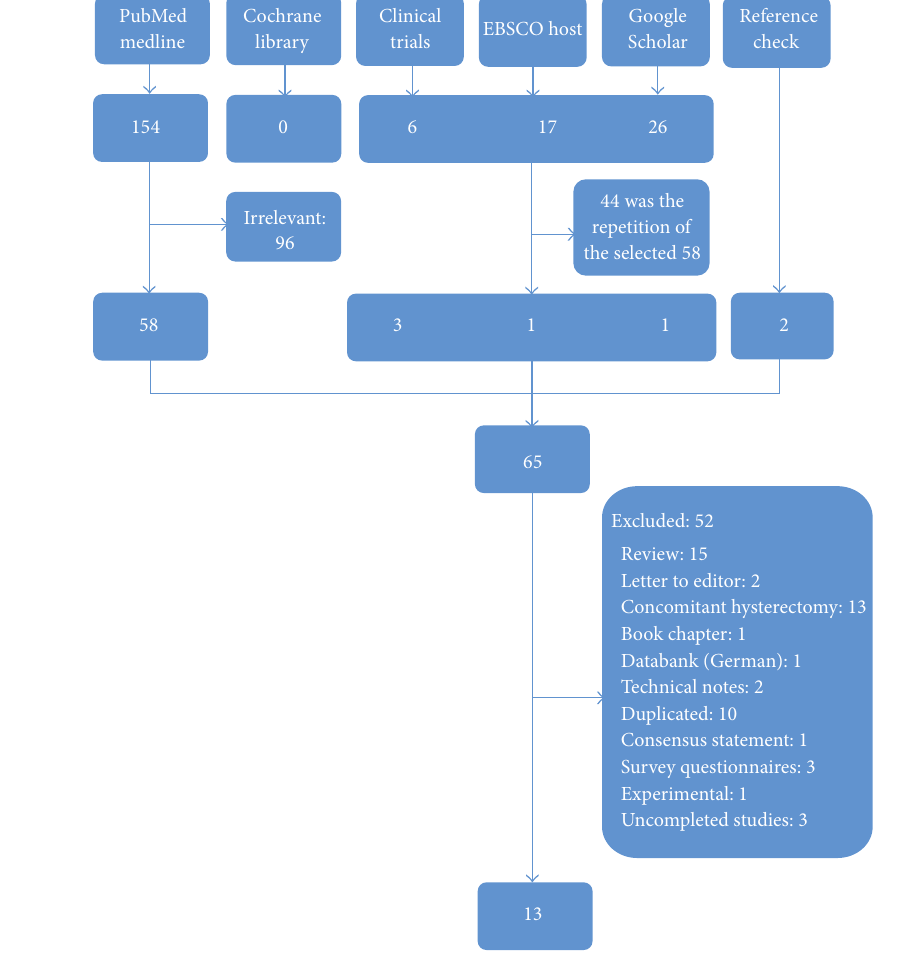
Figure 1: Flowchart of the systematic